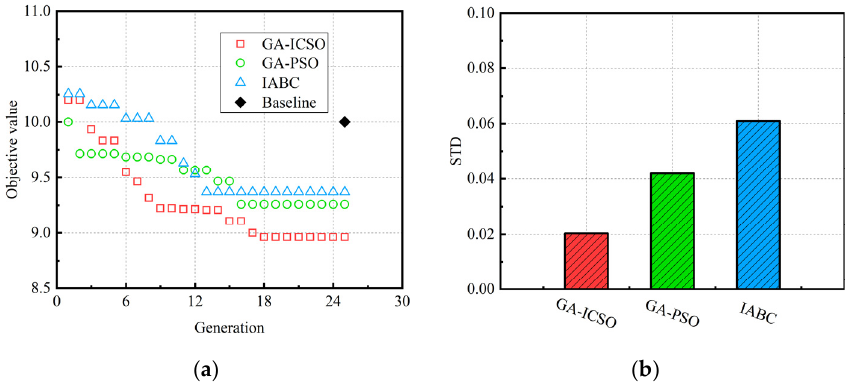
Figure 13. Optimization history of GA-ICSO, GA-PSO and IABC for 50% load: ( a ) Objective function convergence; ( b ) STD.